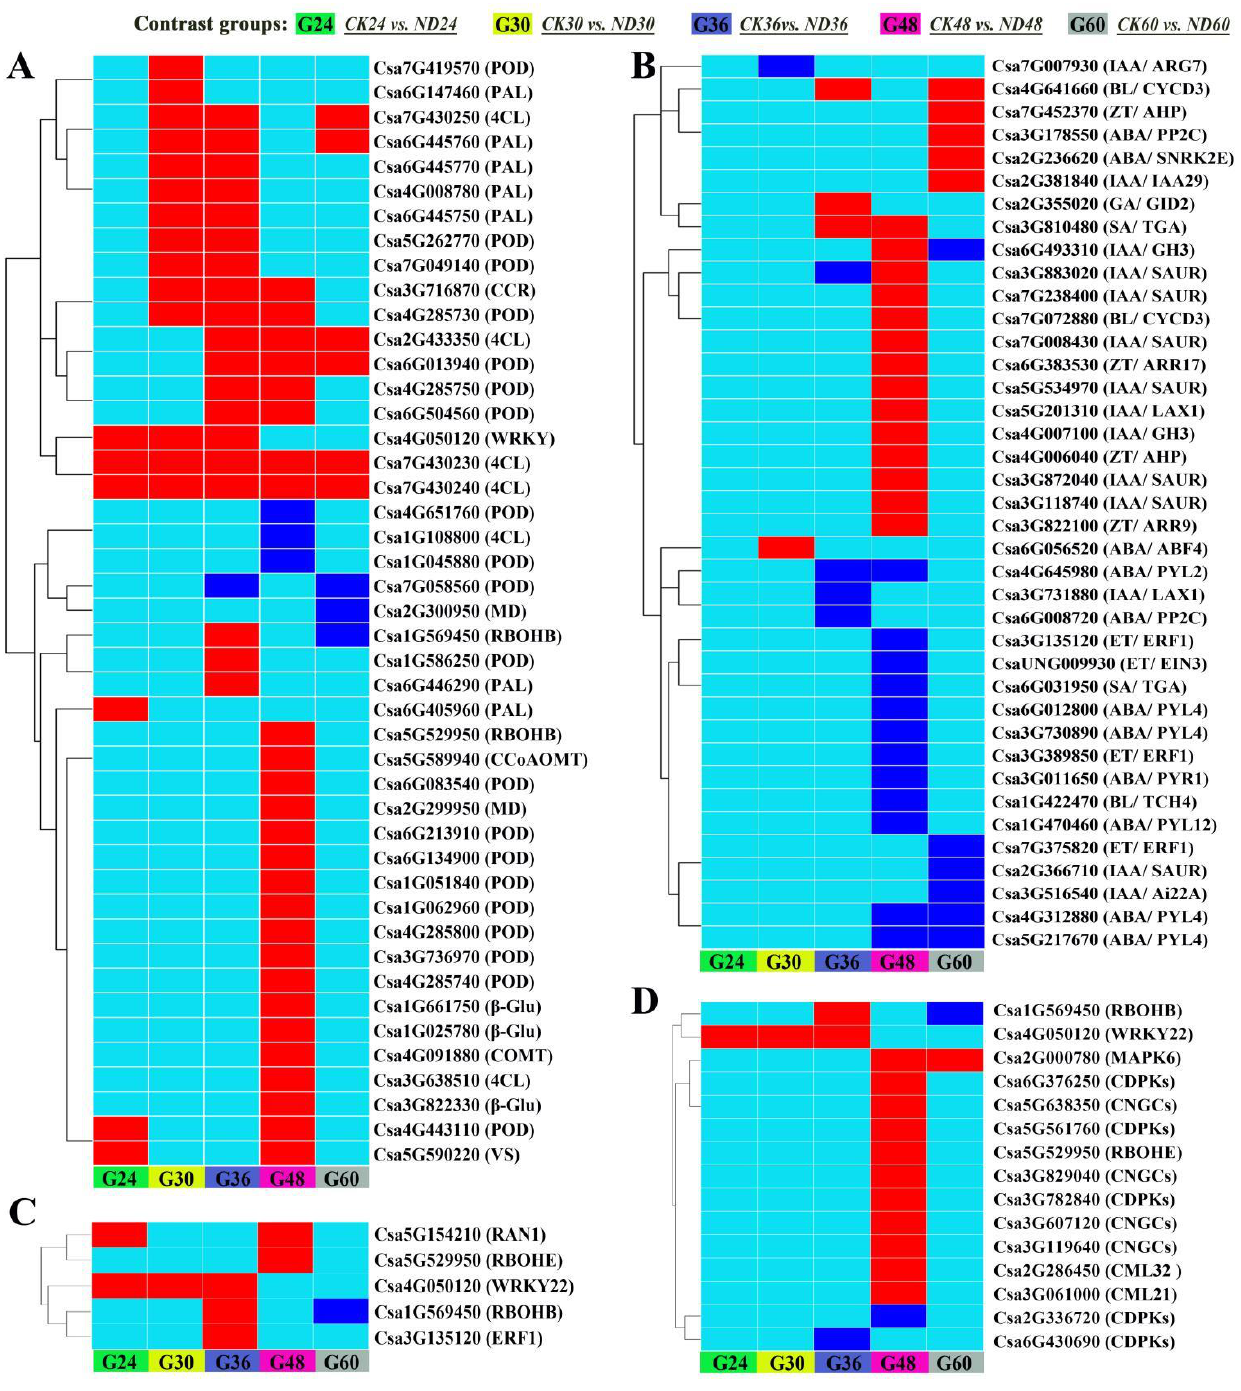
Figure 5. Gene expression patterns of major metabolic pathways in responding to the infection and colonization of C. globosum strain ND35 in cucumber radicle. ( A ): Phenylpropanoid biosynthesis; ( B ): Plant hormone signal transduction; ( C ): MAPK signaling pathway-plant; ( D ): Plant-pathogen interaction. The data point color indicates up-regulation (red), down-regulation (blue), and non- regulation (light blue) that is within the specified contrast group.